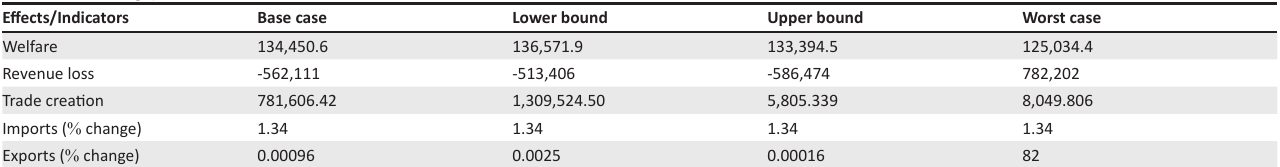
TABLE 11: Robustness and sensitivity analysis of the European Union–South Africa Free Trade Agreement on trade creation, revenue welfare, imports and exports (US$ 1000 and % change). Effects/Indicators Base case Lower